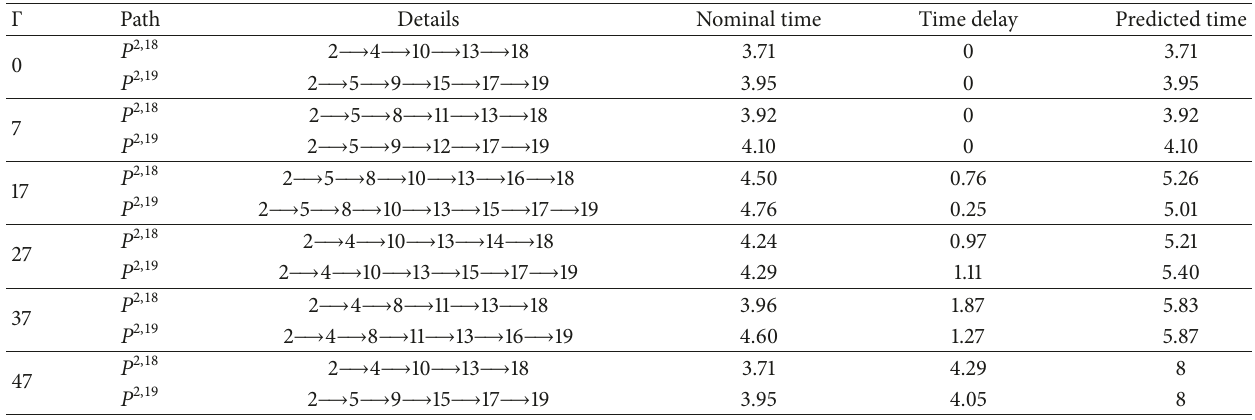
Table 3: The related information of 𝑝 2,18 and 𝑝 2,19 .